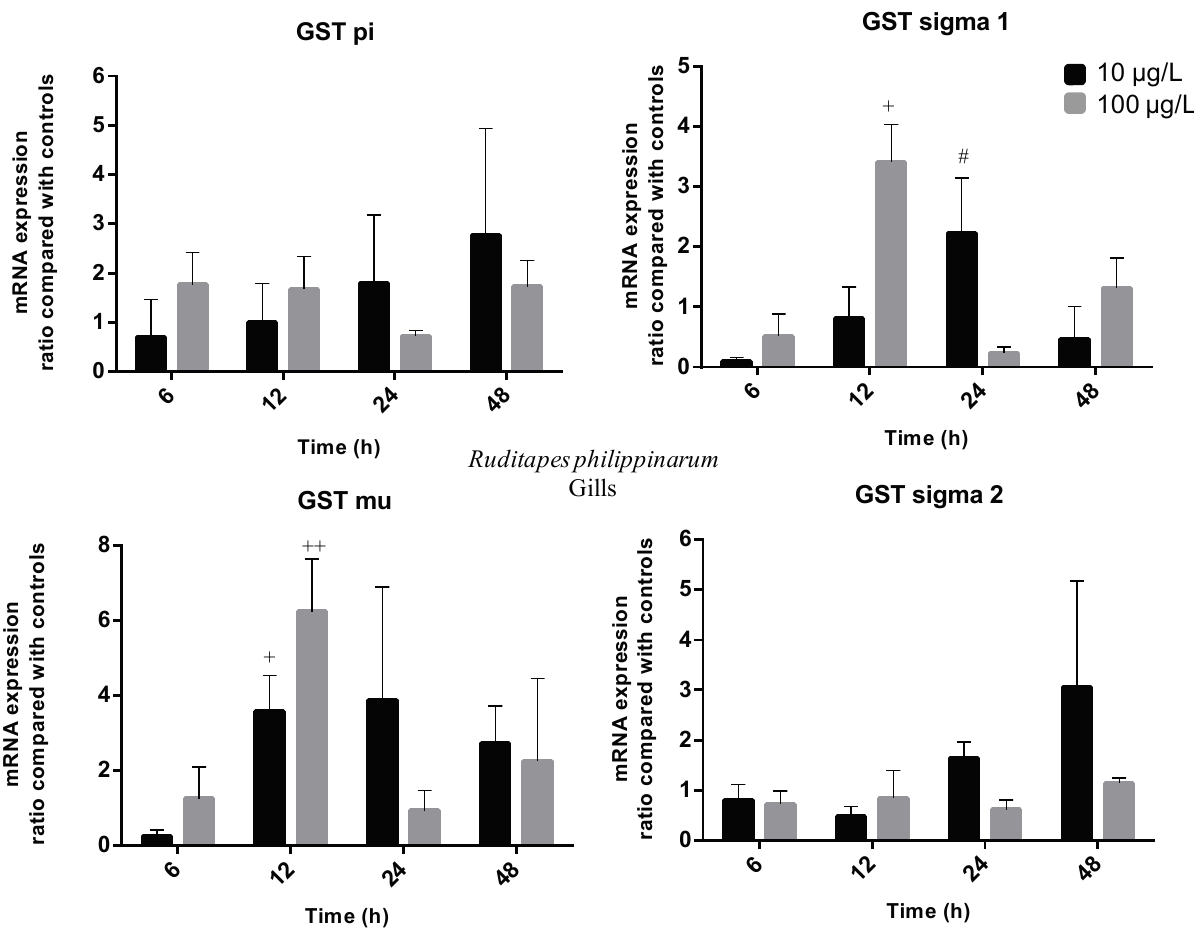
Figure 4. Temporal changes of R. philippinarum gills GSTs transcripts after pure MC-LR exposure compared with controls (Treatment group ratio/Ctrl ratio). Black columns represent low-exposure group (10 µg/L MC-LR) and grey columns represent high-exposure group (100 µg/L MC-LR) (statistically significant differences were accepted at p ≤ 0.05; + indicates differences to Ctrl; ++ indicates differences both to Ctrl and low-exposure group; # indicates differences between exposed